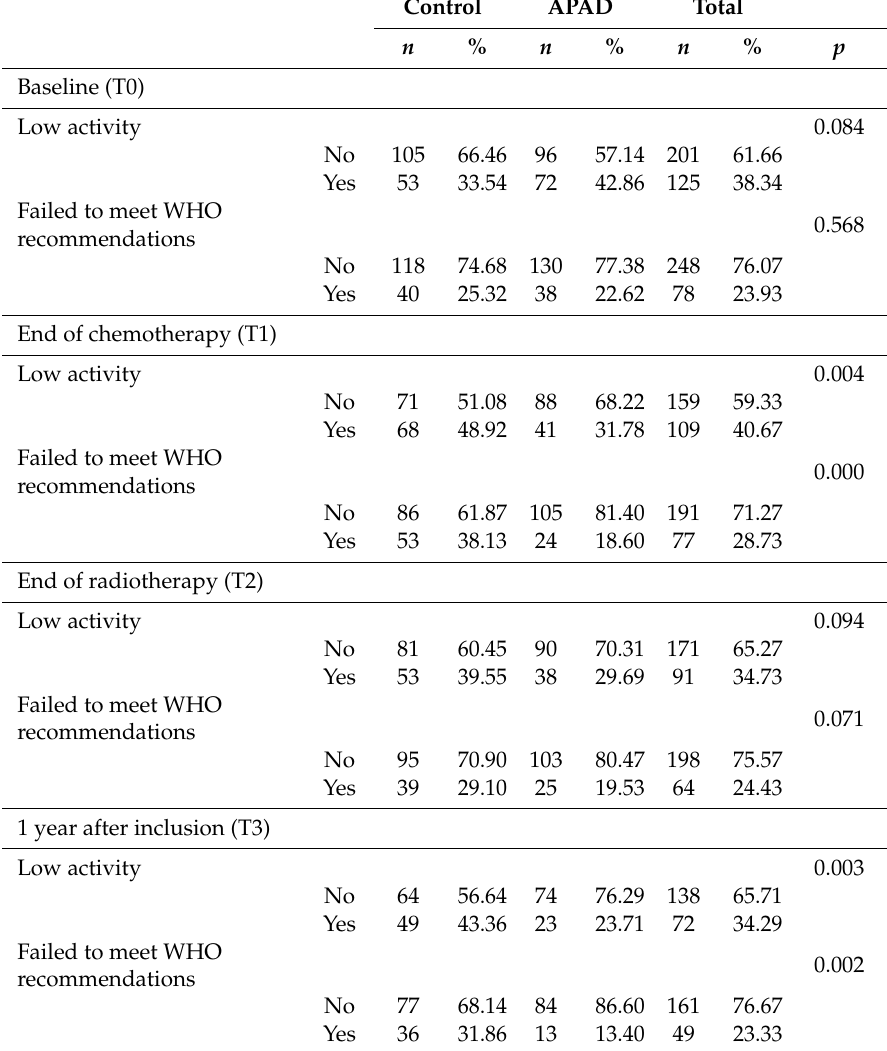
Table 5. Compliance with the WHO Stepwise 1 recommendations for physical activity (GPAQ) in the intention-to-treat